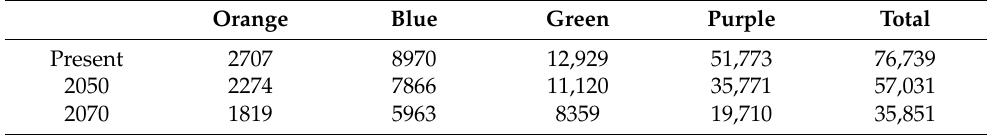
Table 3. Estimated reduction in cork oak populations, distinguished by haplotype, due to change in temperature and precipitation, as predicted for 2050 and 2070 by the thirteen global circulation models listed in Table 1. Numbers refer to residual surfaces expressed as cells of 1 square kilometer containing cork oak forests. The geographical location is shown in Figure